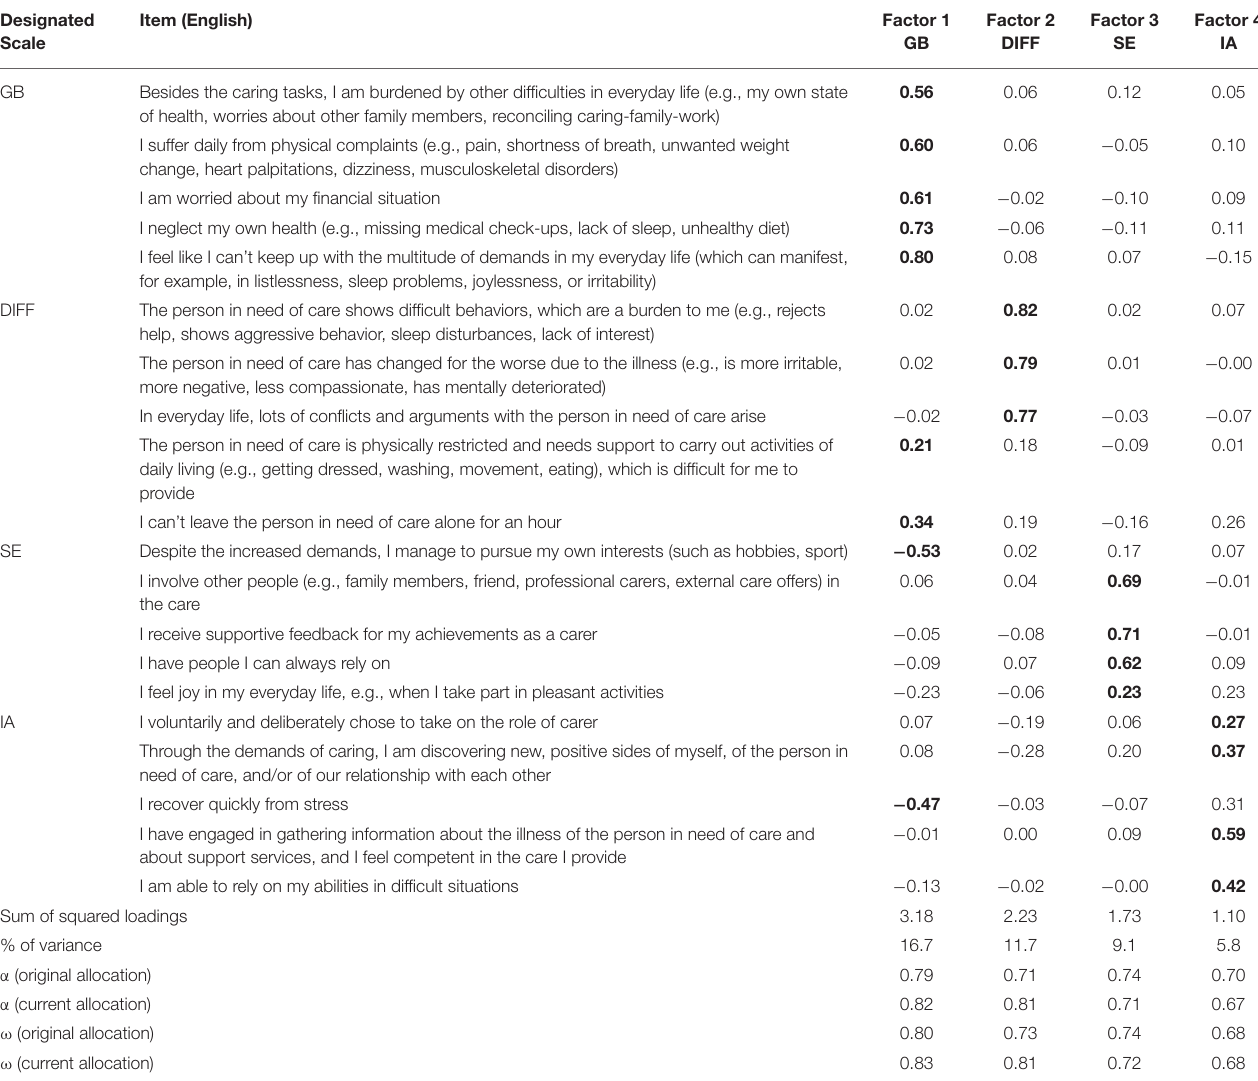
TABLE 3 | Loading pattern and factor loadings of items concerning exploratory factor analysis. Designated